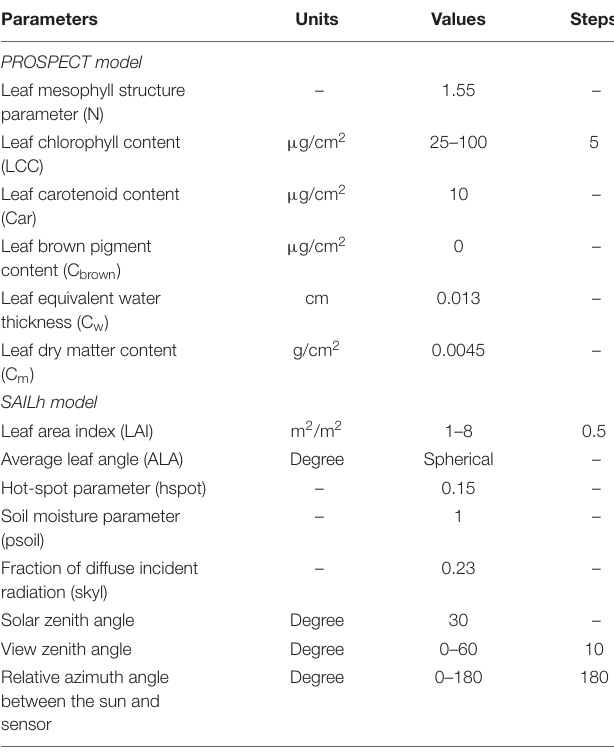
TABLE 2 | Input parameters of PROSAIL